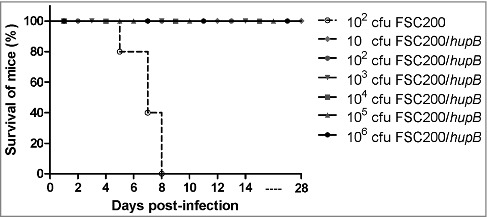
FSC200/hupB mutant is attenuated in in vivo model of tularemia. Groups BALB/c mice, 6–10 weeks old, were infected with 200 μl of bacterial suspension subcutaneously (s.c.) with appropriate infection doses of 101, 102, 103, 104, 105 and 106 CFU/mouse for FSC200/hupB mutant and 102 CFU/mouse for FSC200 and complemented strain FSC200/hupB+hupB. Mice infected by FSC200 died within 8 days after infection. In contrast, neither increasing infection doses of FSC200/hupB cause the death of mice.